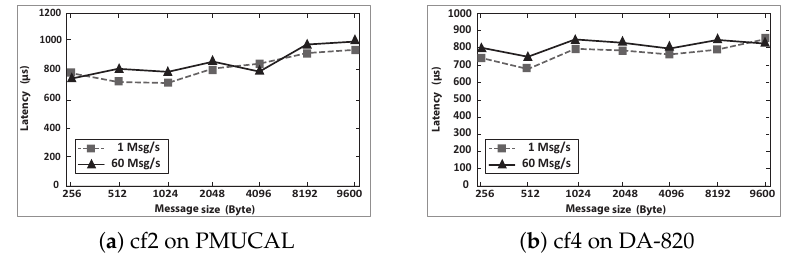
Figure 25. Communication